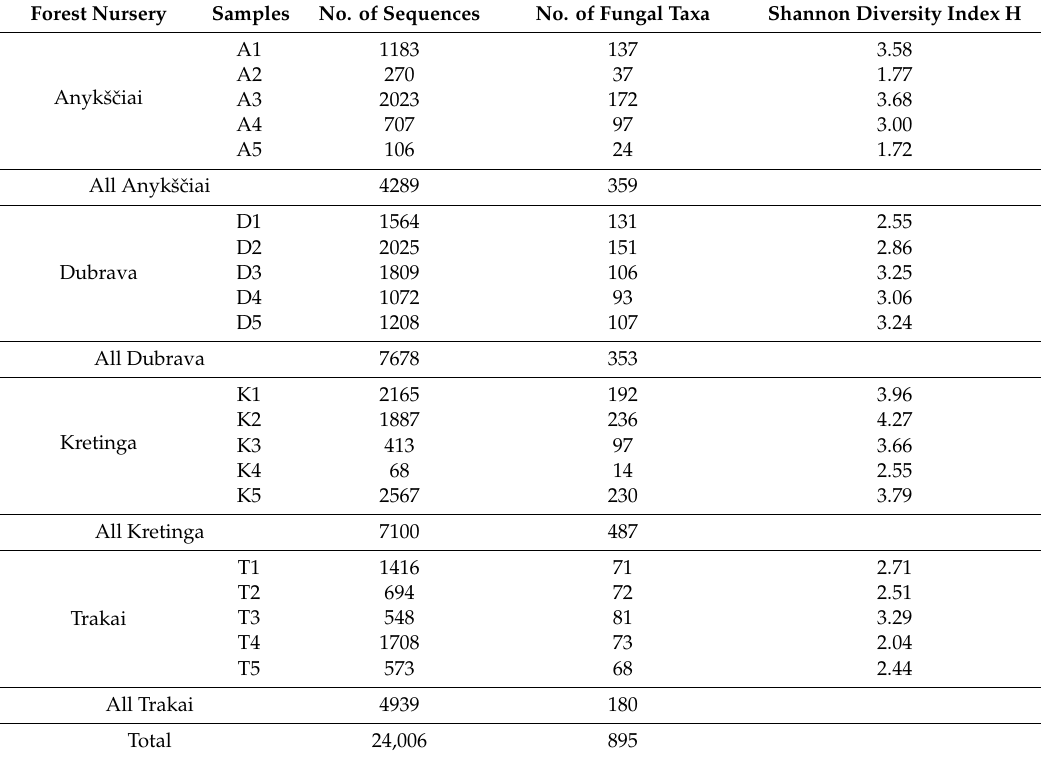
Table 2. Generated high-quality sequences and detected diversity of fungal taxa in water filtrate samples from Anykšˇciai, Dubrava, Kretinga and Trakai forest nurseries in Lithuania. Forest